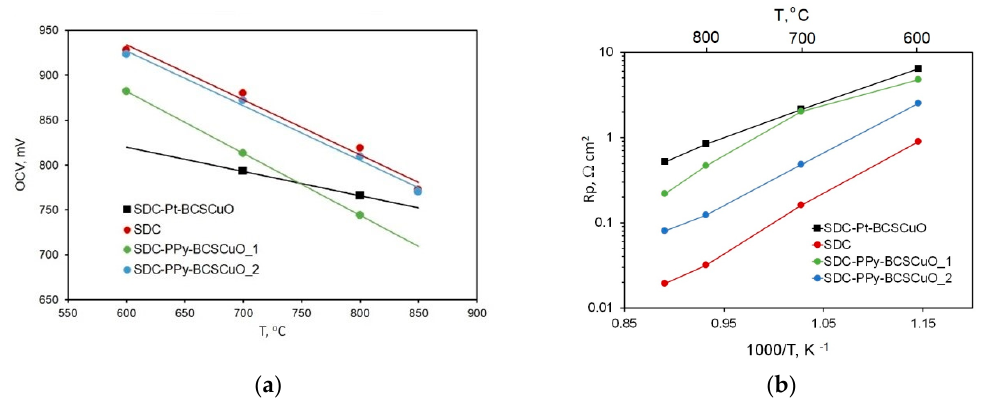
Figure 12 . Testing the SDC-based cells with/without barrier layers under OCV conditions: ( a ) OCV values; ( b ) Polarization resistance of the electrodes.